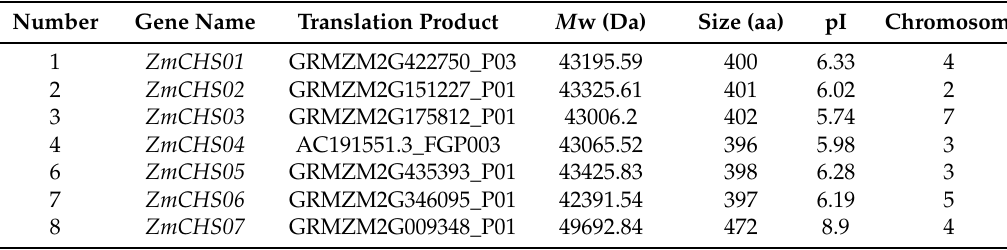
Table 1. The chalcone synthase family genes of